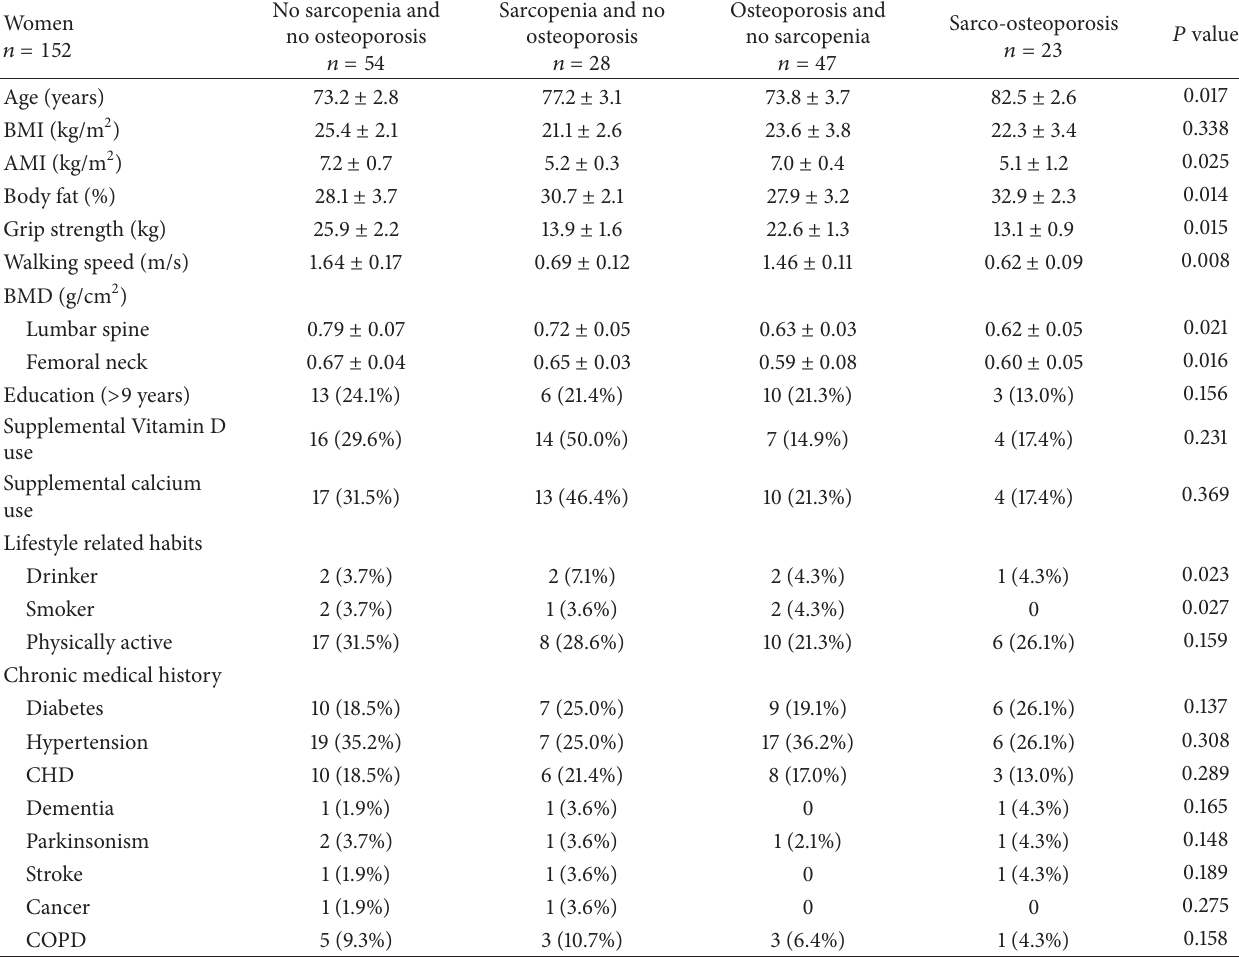
Table 3: Subject characteristics of women by musculoskeletal diseases classification.